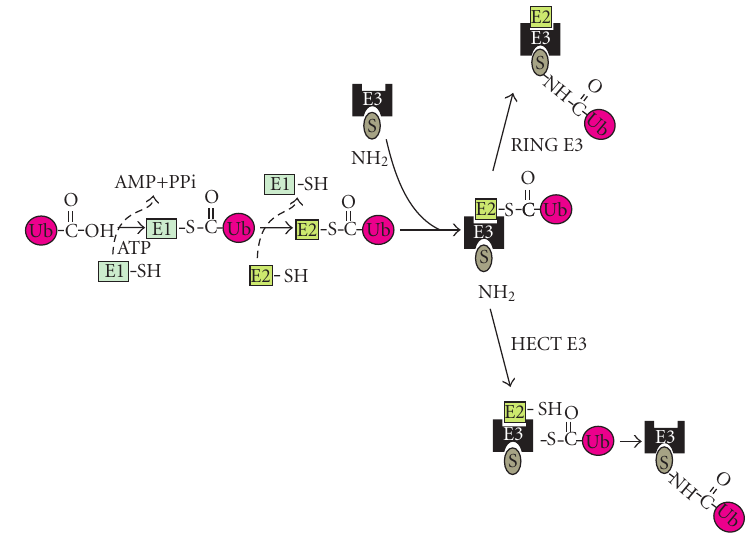
Figure 2: A schematic representation of substrate ubiquitination (see [85]).